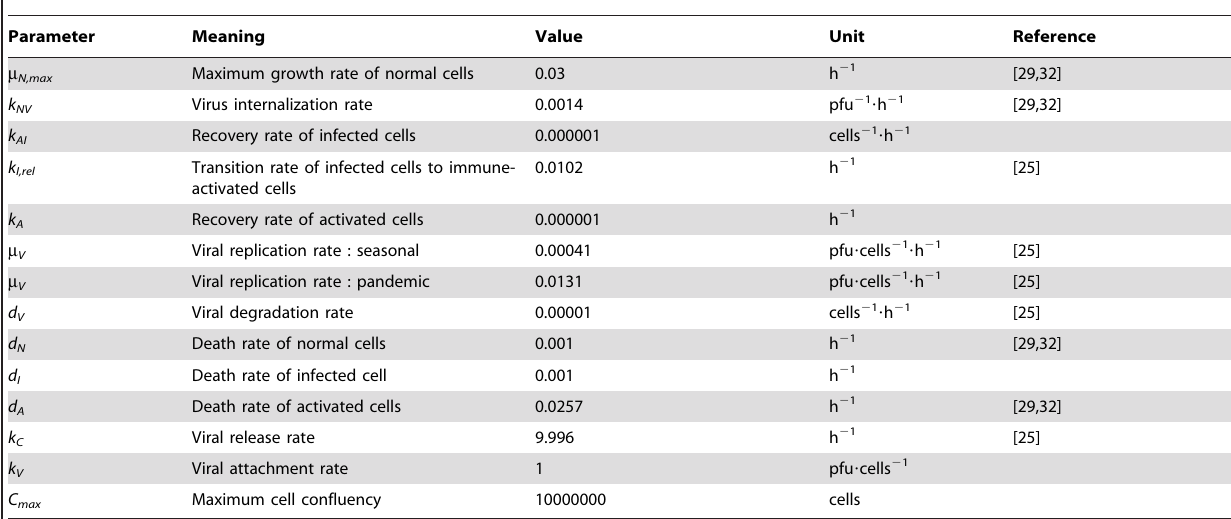
Table 1. Descriptions and values for the model parameters.